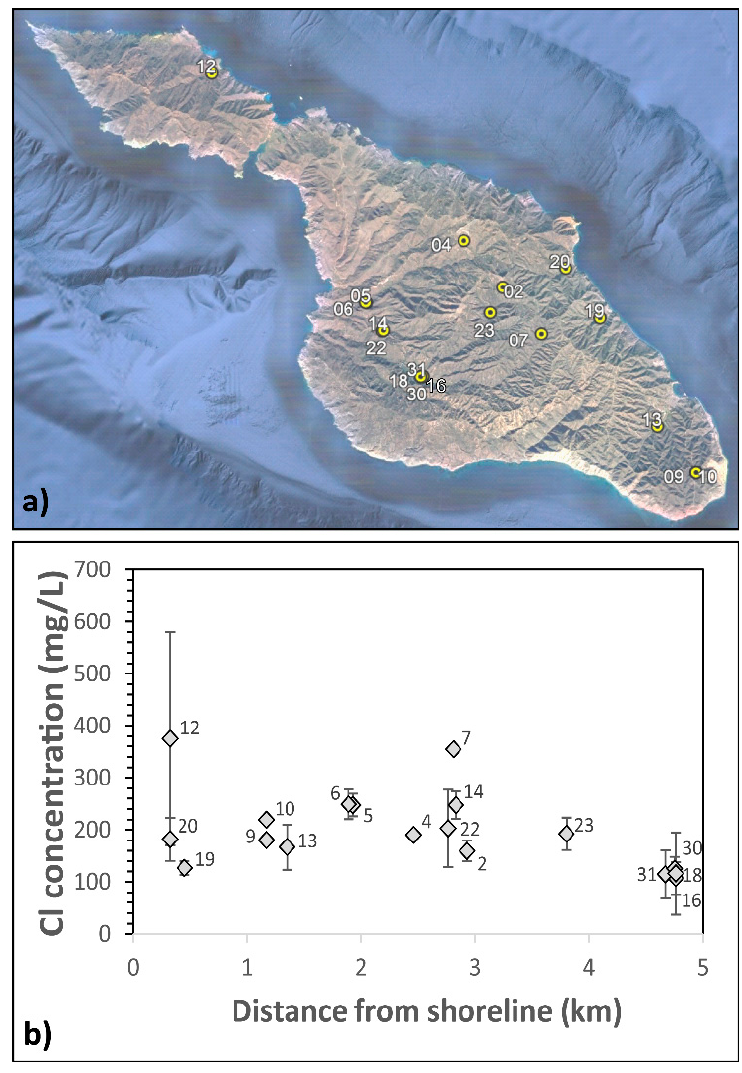
Figure 4. Location of groundwater wells on Catalina with chemical records ( a ) and groundwater Cl range on Catalina for the time period 1989–2017 ( b ). Diamonds indicate geometric means, error bars indicate one standard deviation, and numbers denote well ID.